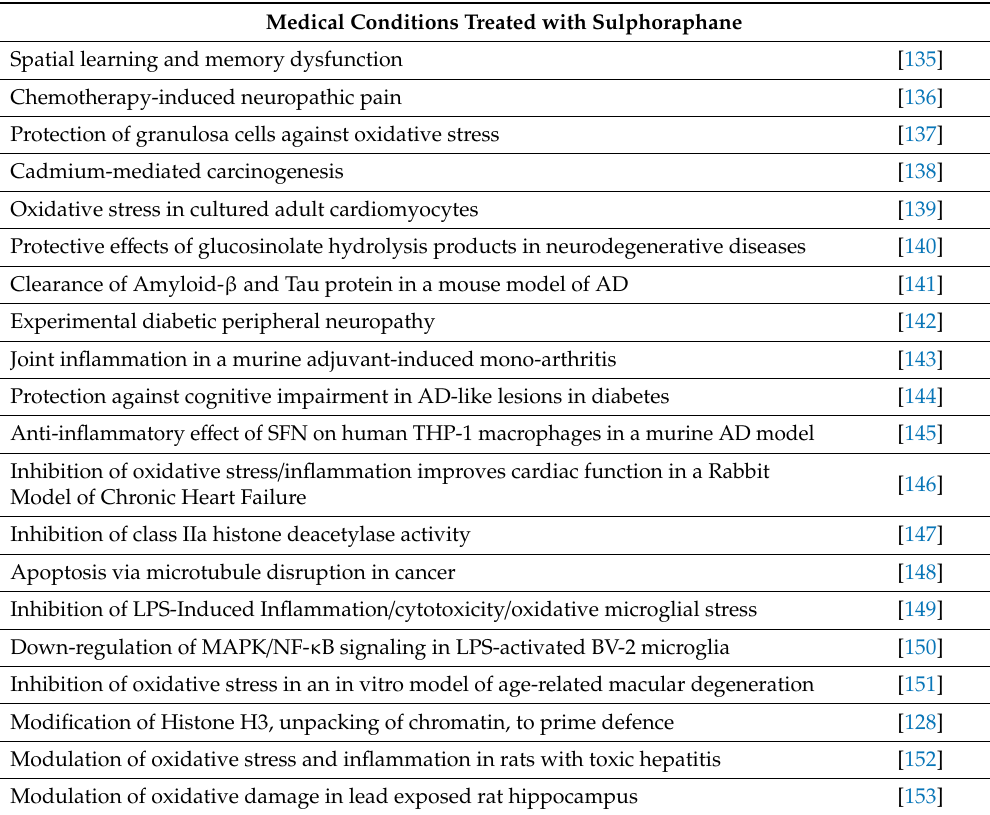
Table 5. Some Examples of The Diverse Therapeutic Applications of